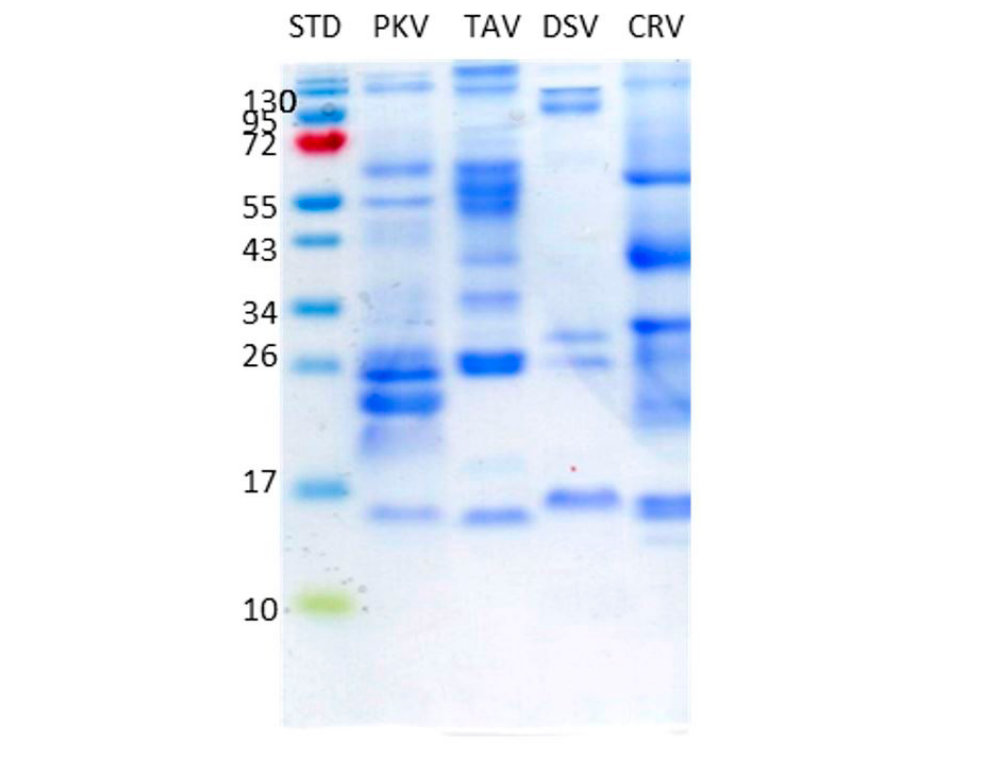
Figure 2. SDS-PAGE patterns of four snake venoms (30 µg/well each) under non-reducing conditions. STD: standard protein markers (Thermo scientific PageRuler Prestained Protein Ladder); PKV: Protobothrops kelomohy venom ; TAV: Trimeresurus albolabris venom; DSV: Daboia siamensis venom ; CRV: Calloselasma rhodostoma